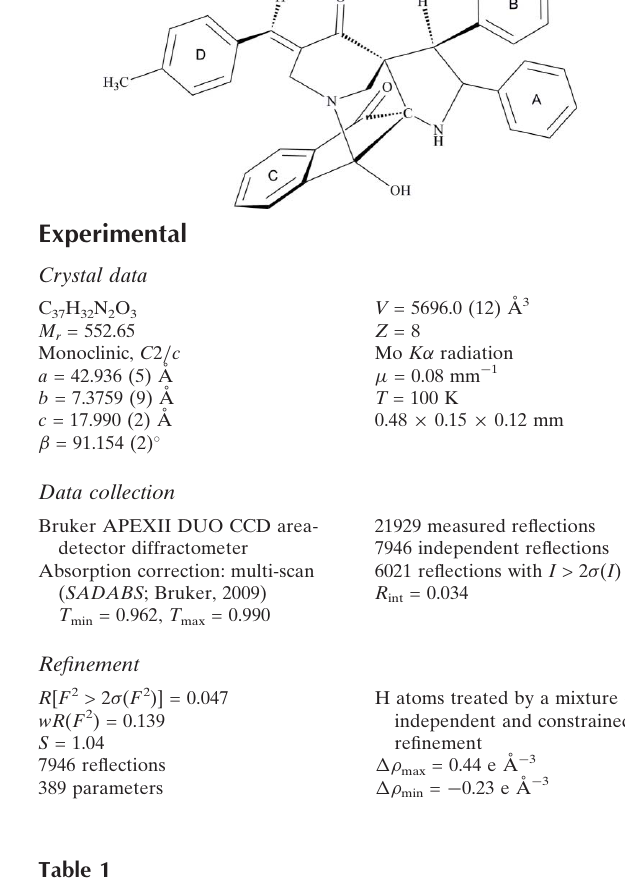
Hydrogen-bond geometry (A˚ , (cid:3) ). Cg 1 and Cg 2 are the centroids of the C9–C14 and C18–C23 benzene rings,